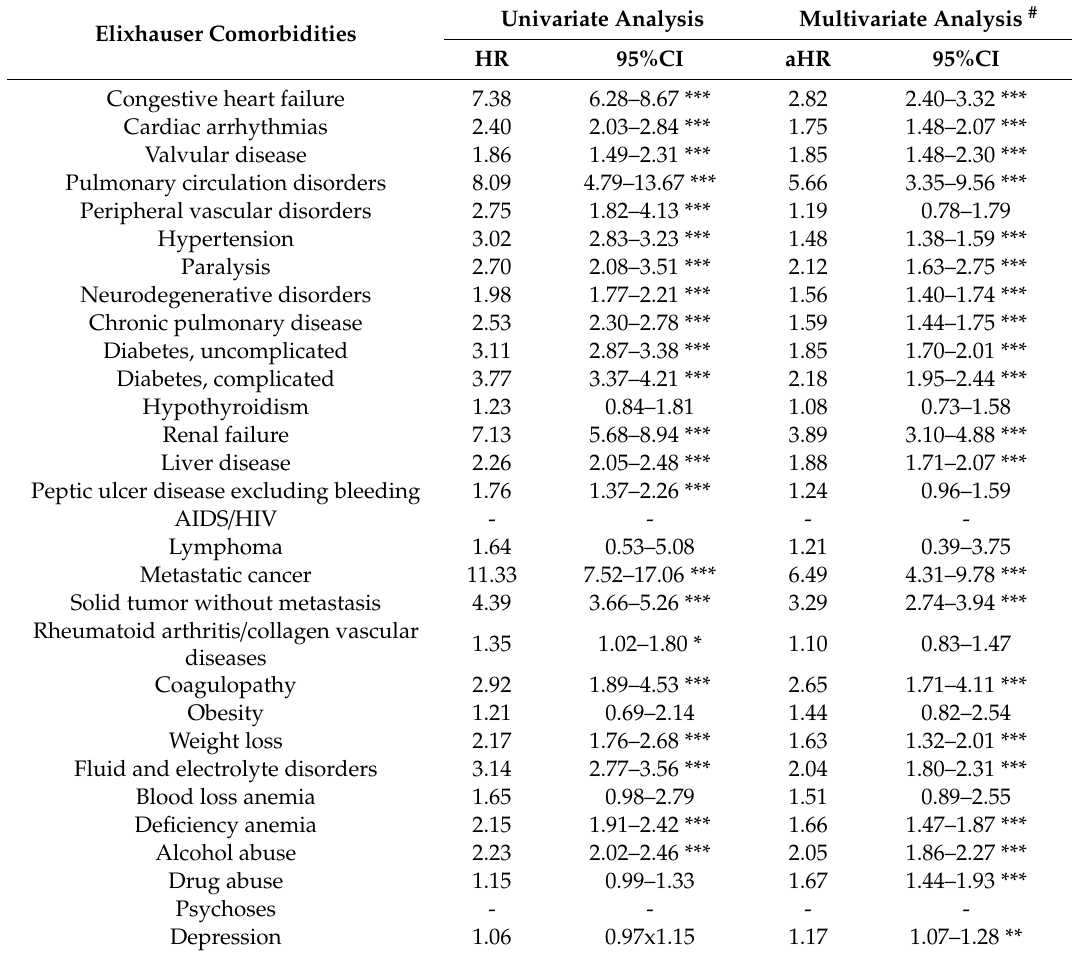
Table 5. Adjusted Hazard Ratios of Mortality Among Patients with Schizophrenic Disorders Based on the Elixhauser Comorbidities.